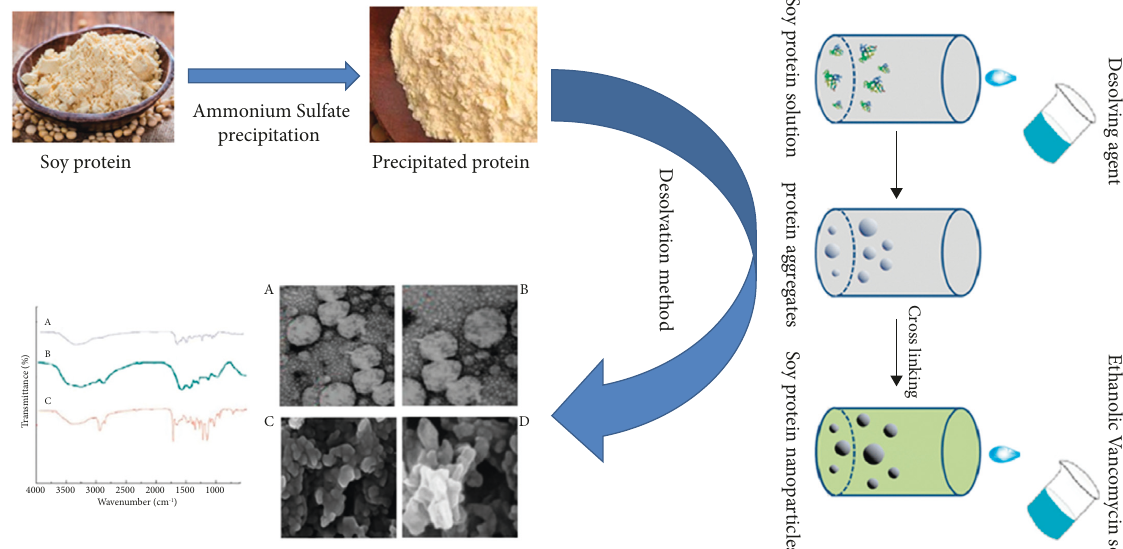
Figure 1: Schematic diagram of synthesis procedure by desolvation